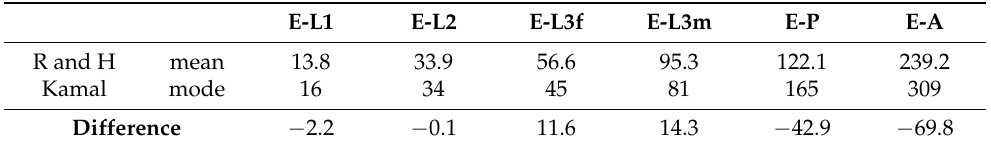
Table 8. Comparison between Kamal [4] and Roe and Higley of Phormia regina development means and modes.